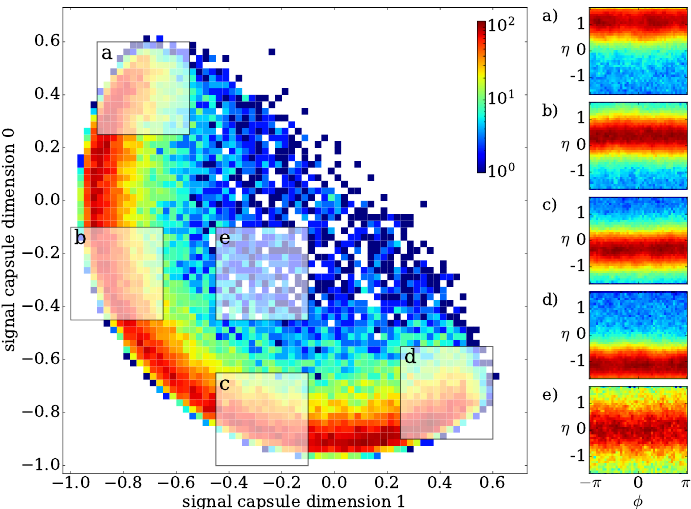
Figure 10: Distribution of the two entries in the 2-dimensional signal capsule for signal events. Right: average event images in the η − φ